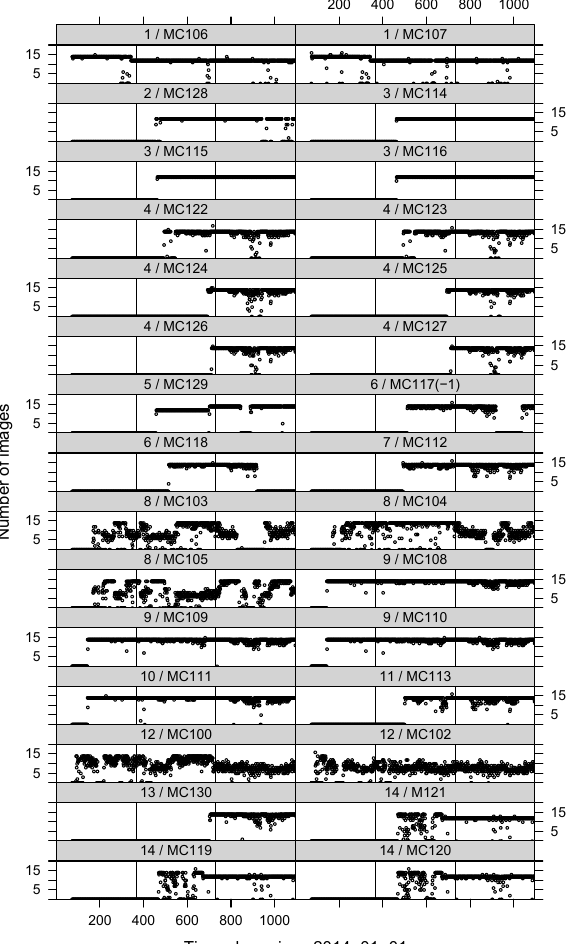
Figure 6. Number of images taken between 09:00 and 15:00UTC + 2. The image archive contains images from longer pe- riod during the day. Cameras do not take images during night hours. Site labels refer to Table